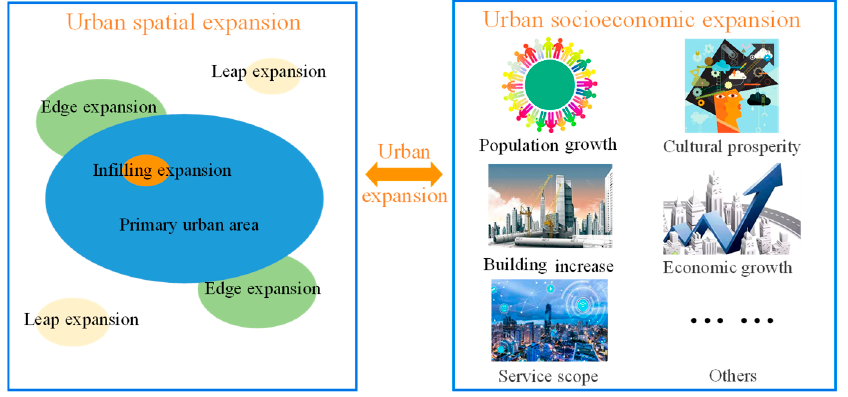
Figure 1. Definition of urban expansion.